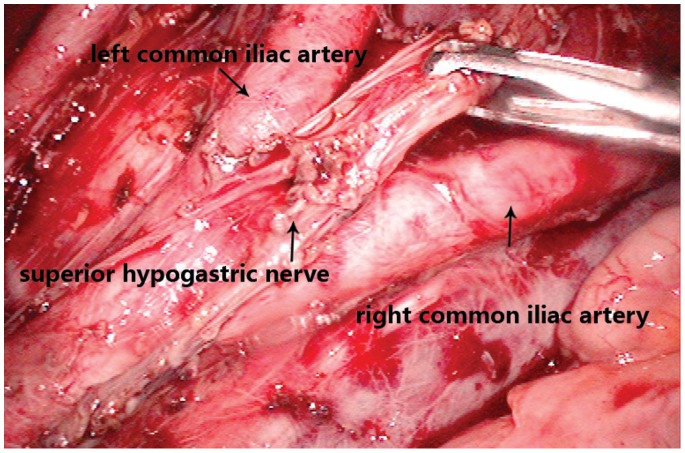
Preseration of autonomic plexus after removal of lymph nodes.Lymph nodes around the common, internal, and external iliac arteries should be removed in this procedure. Ureter should be identified clearly. Autonomic plexus walking in the middle of both sides of the common iliac artery, this feature should be noted during lymp nodes dissection.